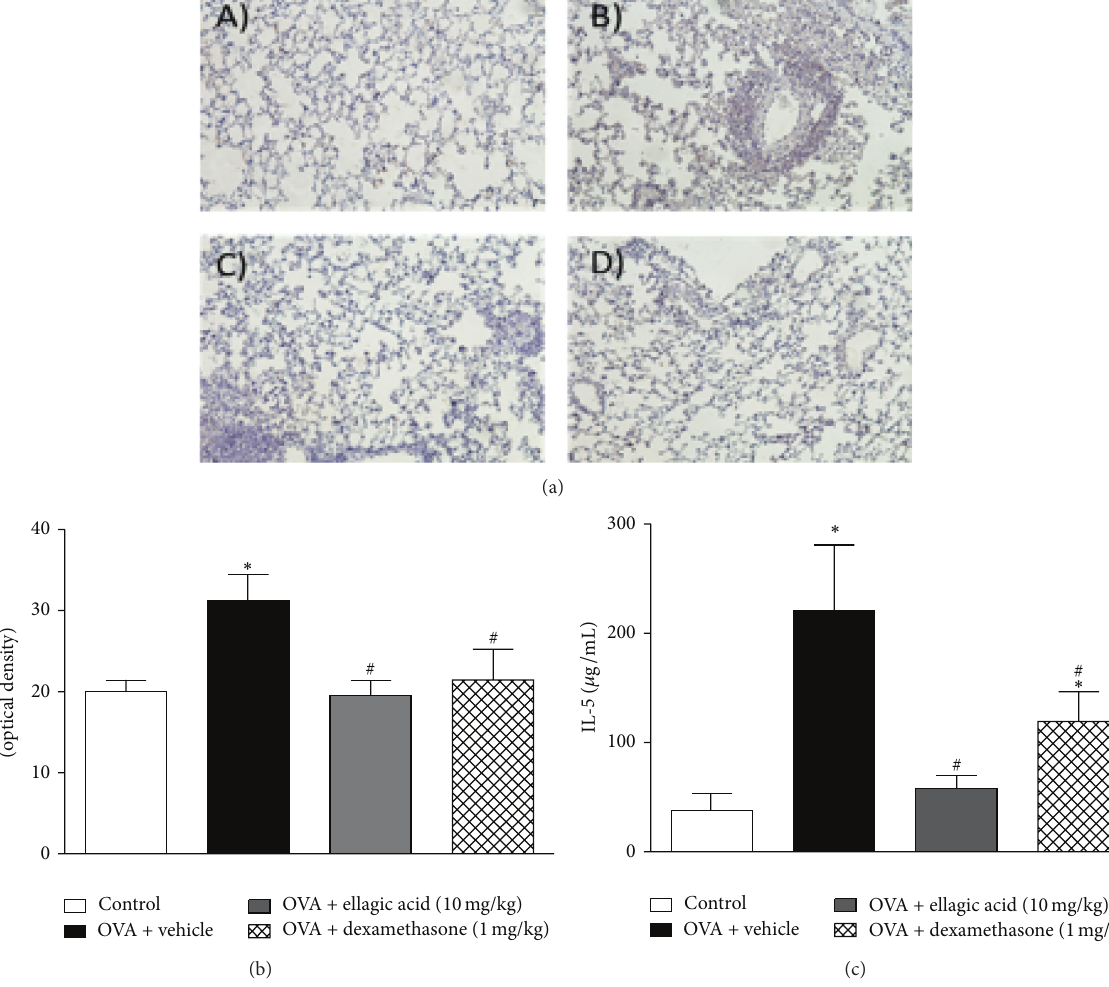
Figure 4: Effect of ellagic acid on P-selectin expression in the lung and IL-5 concentration in the BALF. Representative images of P-selectin immunohistochemistry staining of (A) control; (B) OVA + vehicle; (C) OVA + ellagic acid; (D) OVA + dexamethasone (a). The mean intensity of P-selectin staining was determined from image analysis and represented as arbitrary units (b). The analyses of lung ((a) and (b)) and IL-5 concentration in the BALF (c) were carried out in the resolution phase (at 21 days). Values represent the mean ± SEM ( 𝑛 = 4 per group). ∗ 𝑃 < 0.05 compared with control group; # 𝑃 < 0.05 compared with ovalbumin + vehicle